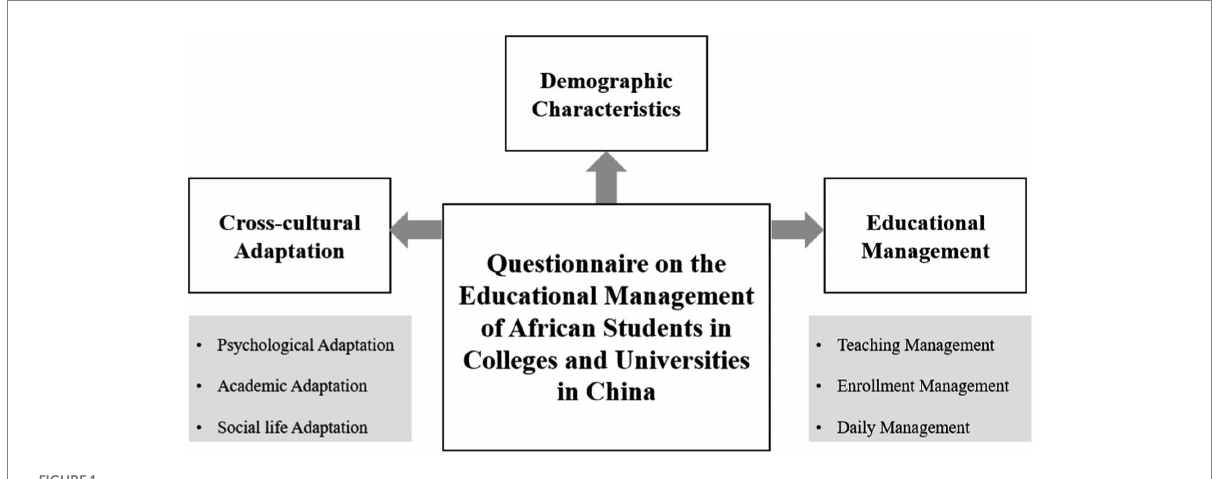
FIGURE 1 Education management of African student at Chinese